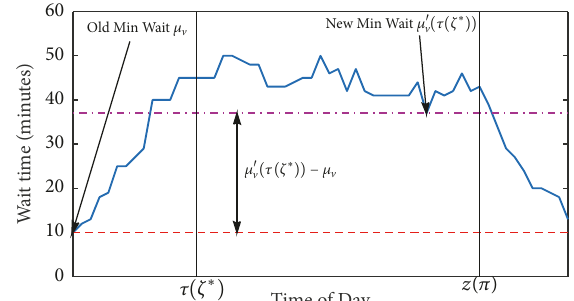
Figure 1: Extra wait time incurred by calculating a new minimum wait time 𝜇 󸀠 V (𝜏(𝜁 ∗ )) for the feasible window of time that node V will be visited, [𝜏(𝜁 ∗ ),𝑧(𝜋)]